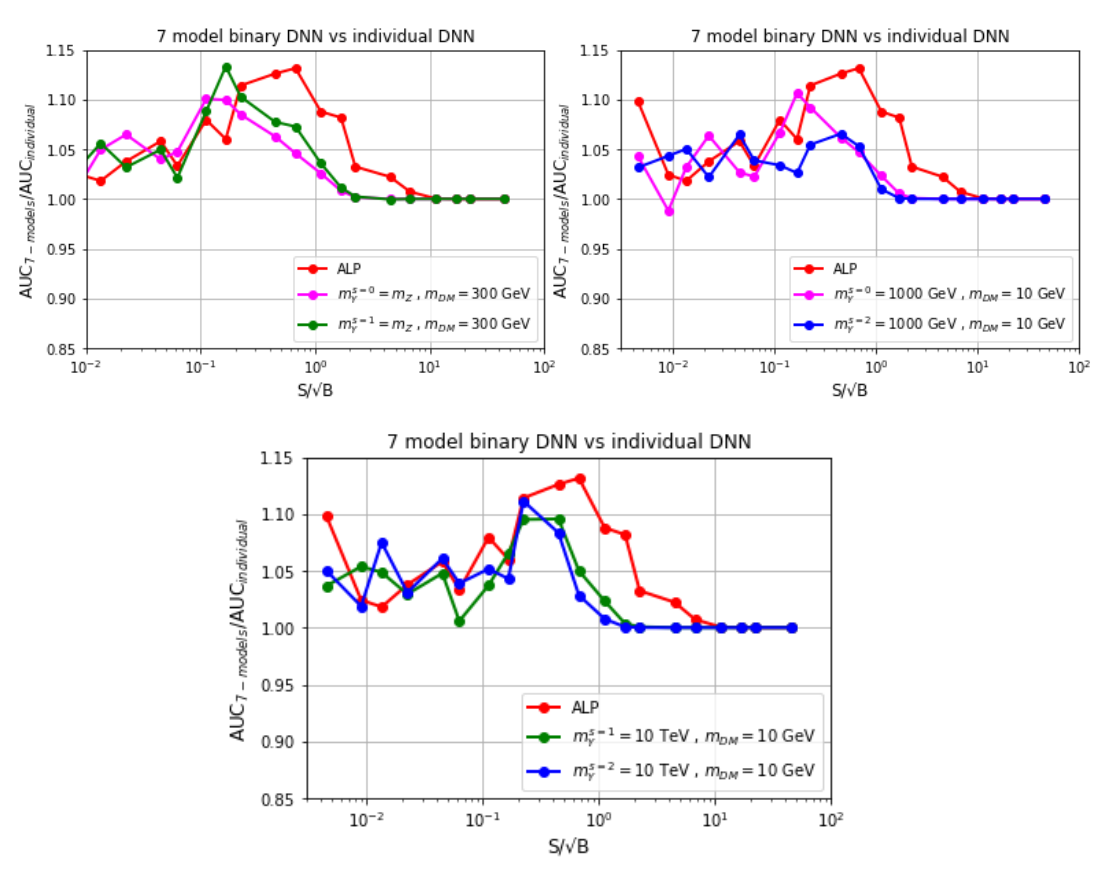
Figure 14: AUCs obtained by applying a test sample of a single model to a DNN trained with 7 different models, AUC , divided by the AUCs obtained by apply- 7-models ing the previous test sample to a DNN trained with a matching data set, AUC . individual Each model is tested independently in a binary classifier to distinguish new physics plus SM vs SM-only